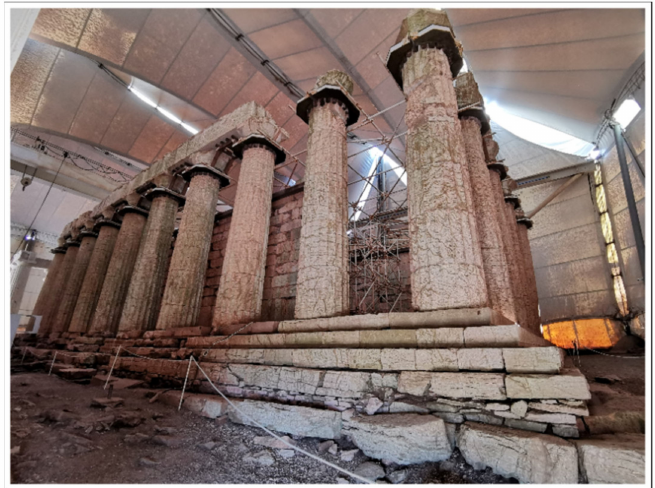
Figure 3. The Temple of Apollo Epikourios at